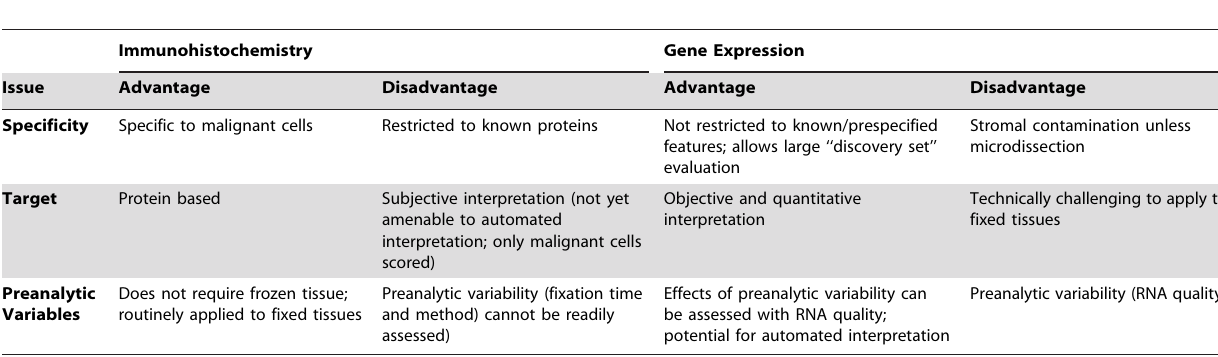
Table 3. Comparison of the advantages and disadvantages of IHC versus gene expression for tumor assessment (e.g.